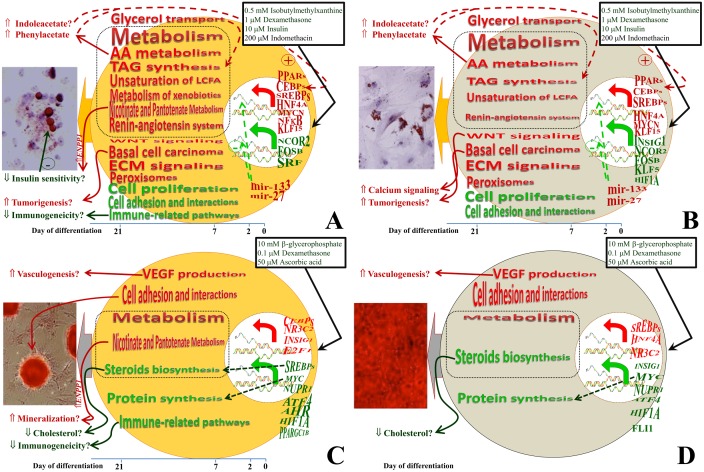
Overall functional adaptation of porcine ASC and BMSC during adipogenic and osteogenic differentiation.The model encompasses the most impacted and enriched terms plus transcription factors inferred by the analysis of transcriptomics changes in ASC and BMSC during adipogenic and osteogenic differentiation. The red font denotes induction while green font denotes inhibition. Shapes of the terms indicate an increase or decrease of the function from pre-differentiation (time 0) to 21 days of differentiation (from right to left). The analysis suggested that ASC during adipogenic differentiation (panel A) had a large transcriptomics change (↰ (red arrow) genes whose transcription was increased; ↰ (green arrow) genes whose transcription was decreased; larger the size larger the number) with a more pronounce number of down-regulated compared to up-regulated genes. On the right, before the arrows, are reported the symbol of the most important transcription factors (TF) apparently regulating the genes affected by differentiations in each cell types. Red font TF are estimated to be activated and green are estimated to be inhibited. Shape of the TF denote change in activation (if larger in red from right to left → more activated during differentiation; if larger in green from right to left → more inhibited during differentiation; shape are derived from data reported in Fig 6). The functional analysis suggested an overall large induction of metabolism, encompassing triacylglycerol (TAG) synthesis with a fundamental role of unsaturation of long-chain fatty acids (LCFA) and import of glycerol. The amino acid (AA) metabolism, the metabolism of nicotinate and nicotinamide metabolism and pantothenate and CoA biosynthesis were induced with likely production of metabolites capable of direct or indirect positive effect on adipogenesis, partly through PPARγ. The ECM signaling, xenobiotics metabolism, and peroxisome were strongly induced. A potential increase in tumorigenesis by adipogenic differentiation can be deduced by the data. The cell proliferation and the cell-to-cell interactions were evidently inhibited by adipogenic differentiation. The transcriptomics data indicated also a large inhibition of immunogenicity as differentiation progressed in ASC. Functional analysis of transcriptomics changes by adipogenic differentiation in BMSC (panel B) suggested a very similar effect as for ASC. The osteogenic differentiation in ASC (panel C) and BMSC (panel D) was characterized by an increase in overall metabolism (larger in ASC vs. BMSC) but with an overall decrease of steroid biosynthesis and protein synthesis machinery. Data also indicated an overall increase in cell adhesion and accumulation of ECM with components such as collagen, and an increase in VEGF production with a likely consequent intensification of angiogenesis (if in an in vivo setting). Amid transcription factors the data suggested a pivotal role of PPAR isotypes and other transcription factors known to be involved in regulating lipid metabolism in controlling adipogenesis and novel TF in regulating osteogenesis. As for the adipogenic differentiation, also for the osteogenesis the data suggested that ASC were characterized by a decreased immunogenicity and an intensification of mineralization by the augmented expression of ectonucleotide pyrophosphatase/phosphodiesterase 1 (ENPP1) that plays a pivotal role in the nicotinate and nicotinamide metabolism and pantothenate and CoA biosynthesis.